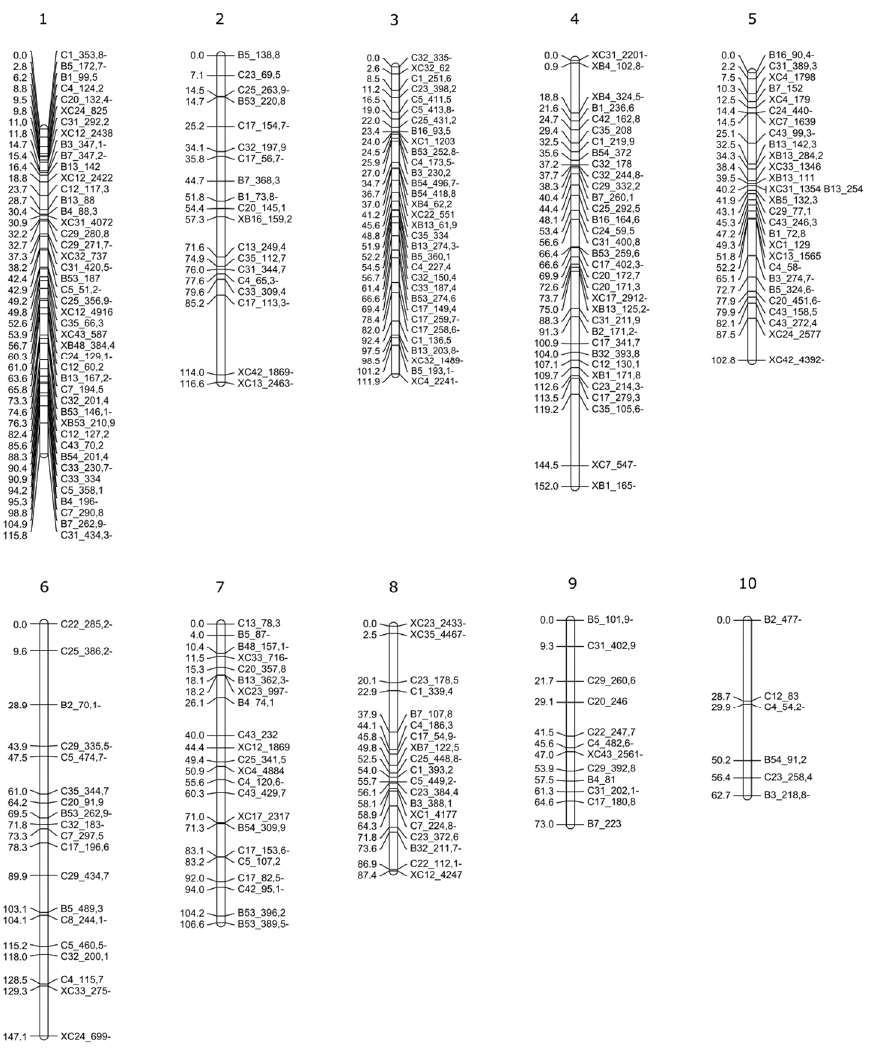
Figure 5. Linkage map of the diploid (2 n = 2 x ) maternal genotype of P. rufum (R6#45). Markers and distances in cM (Kosambi) are indicated on the right and left, respectively. Each co-segregation group includes SDAF and BSDF (starting with an X) markers in coupling and repulsion-phase (-). Based on bi-parental markers segregation, it was possible to identify eight out of the ten female and male homologous LGs (Figure 7, Supplementary Materials Table S4). As there were no bi-parental markers on the LG6 and LG10 numbers, they were arbitrarily assigned (Figures 5 and 6). The relative order between bi-parental markers in both maps showed that most of them are equally ordered in maternal and paternal maps (Figure 7).